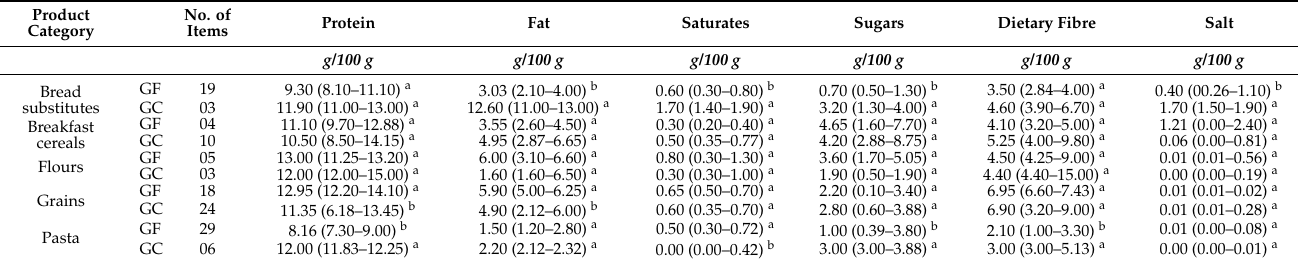
Table 3. Protein, fat, sugars, dietary fibre and salt content across the five food categories with both gluten-free and gluten-containing